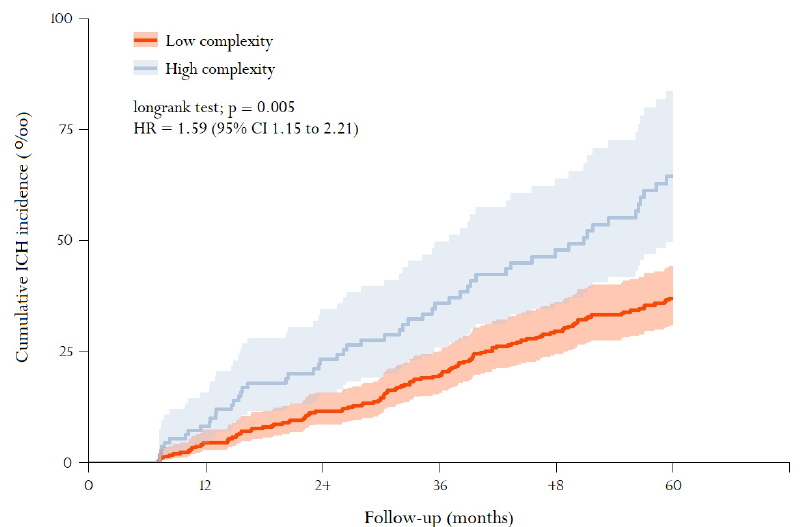
Figure 2. Cumulative ICH incidence according to GMA-complexity group. Kaplan–Meier survival analysis stratified by complexity group (categorised low [levels 2–3] and high [levels 4–5]). The graph shows the cumulative incidence of intracerebral haemorrhage (ICH), calculated as the number of cases that appeared during follow-up (60 months) divided by the number of patients who were disease-free at baseline (‰), with 95% confidence intervals (CI). The bold line corresponds to the value of the accumulated incidence, while the shaded area represents 95% CIs. The log-rank test is used to analyse statistical differences between the survival curves. Cox regression analysis as- sessing multivariate-adjusted variables: sex, age (categorised ≥ 80 years), GMA complexity (Spanish acronym for Adjusted Morbidity Group), stroke or transient ischemic attack and use of pharmaco-